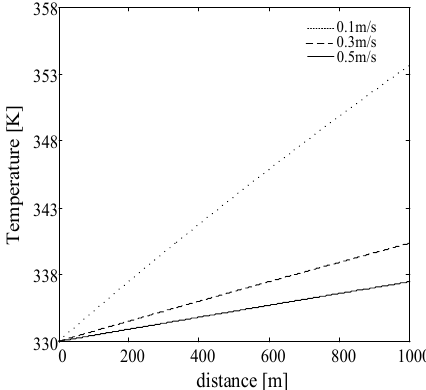
Figure 1. Temperature distribution curve of heavy oil pipeline.